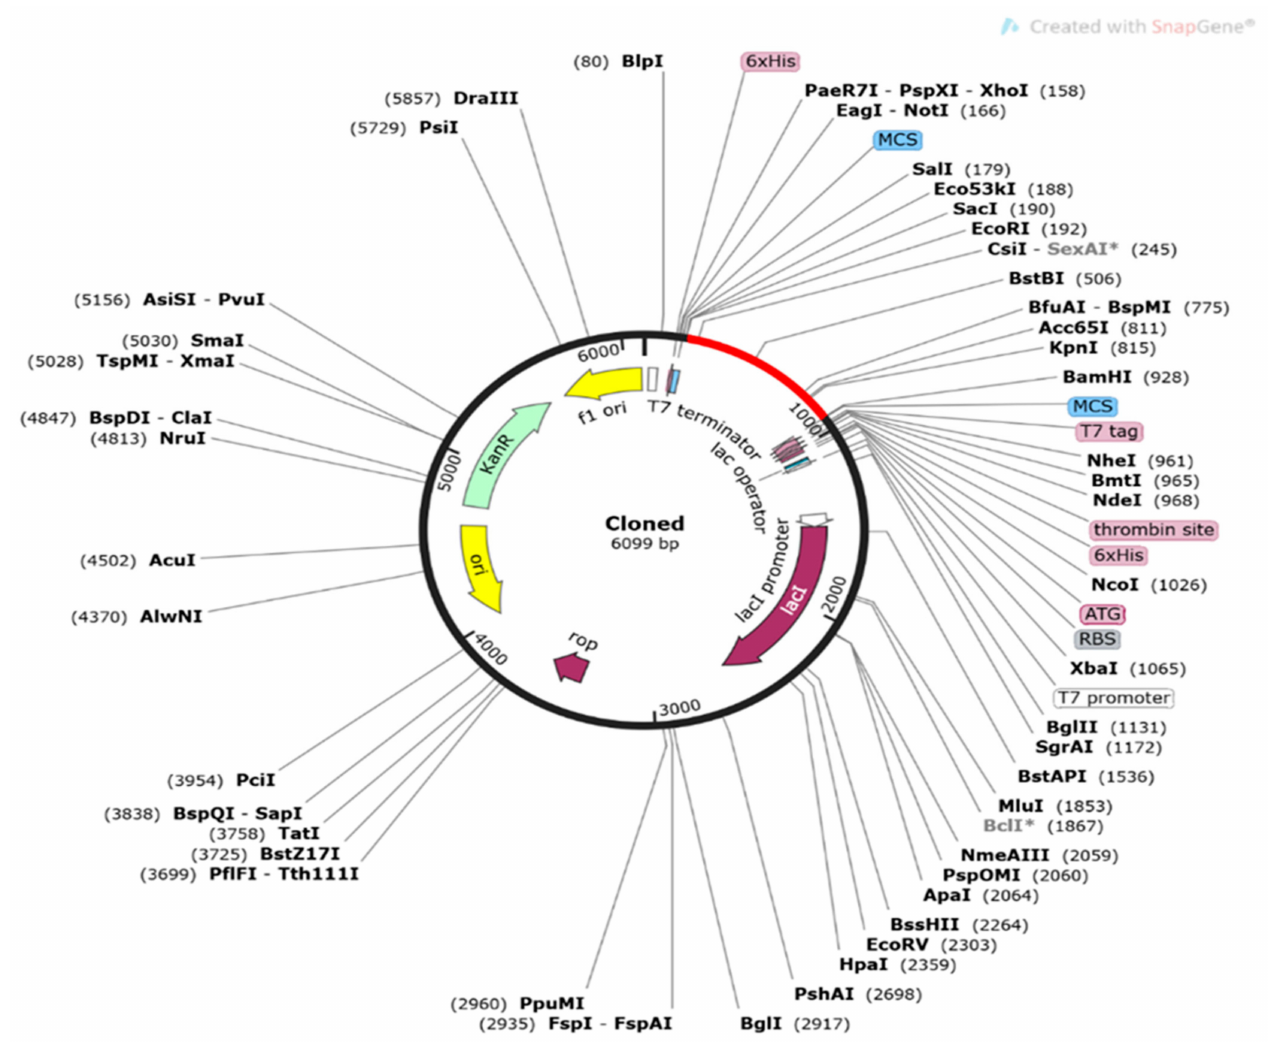
Figure 16. In silico restriction, cloning was used to introduce the final vaccine construct into the pET28a (+) expression vector, in which the red area represents the vaccine insert as well as the black circle represents the